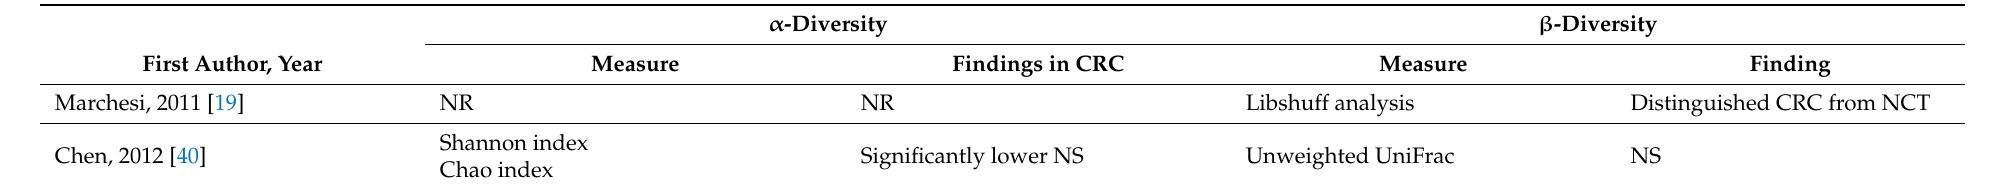
Table 4. Summary of the diversity findings in the mucosal microbiota of CRC and non-cancerous mucosal tissues. α